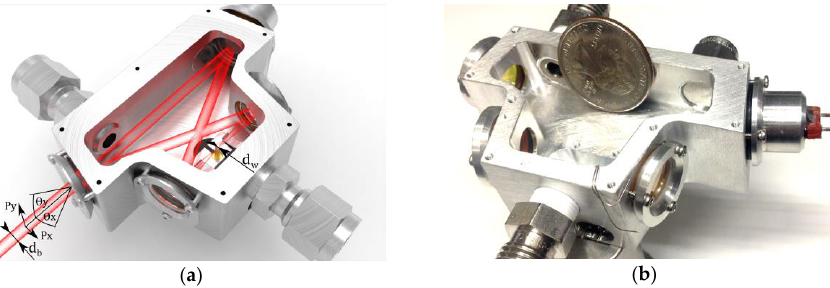
Figure 6. ( a ) Optical cavity 3D design; and ( b ) photo of a novel and compact bow-tie resonator for an I-QEPAS sensor system.